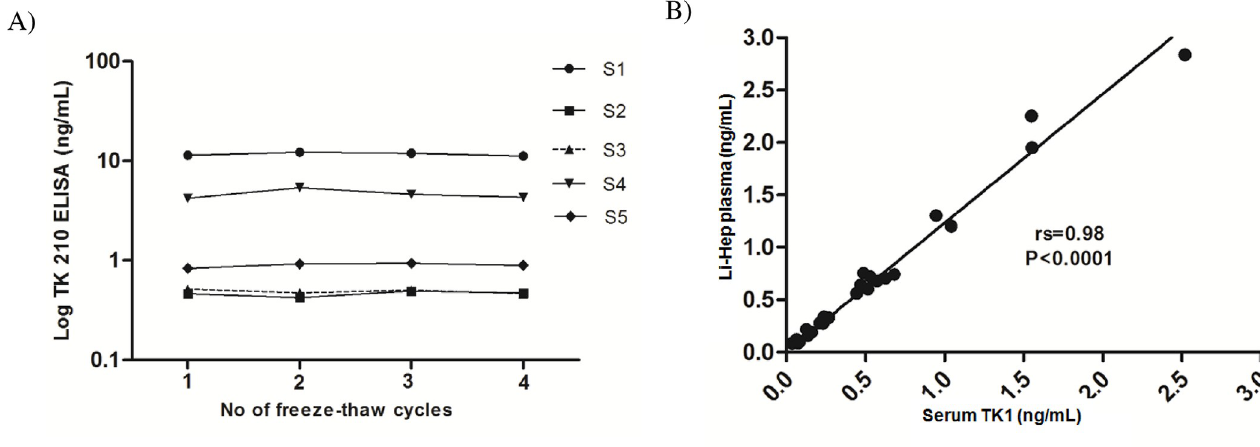
Fig 4. Effect of freeze-thaw cycles and sample type on TK 210 ELISA. (A) Effect of freeze and thaw cycles on the serum TK1 protein concentrations determined with AroCell TK 210 ELISA. (B) Correlation between serum TK1 and lithium heparin plasma TK1 protein levels in clinical samples.